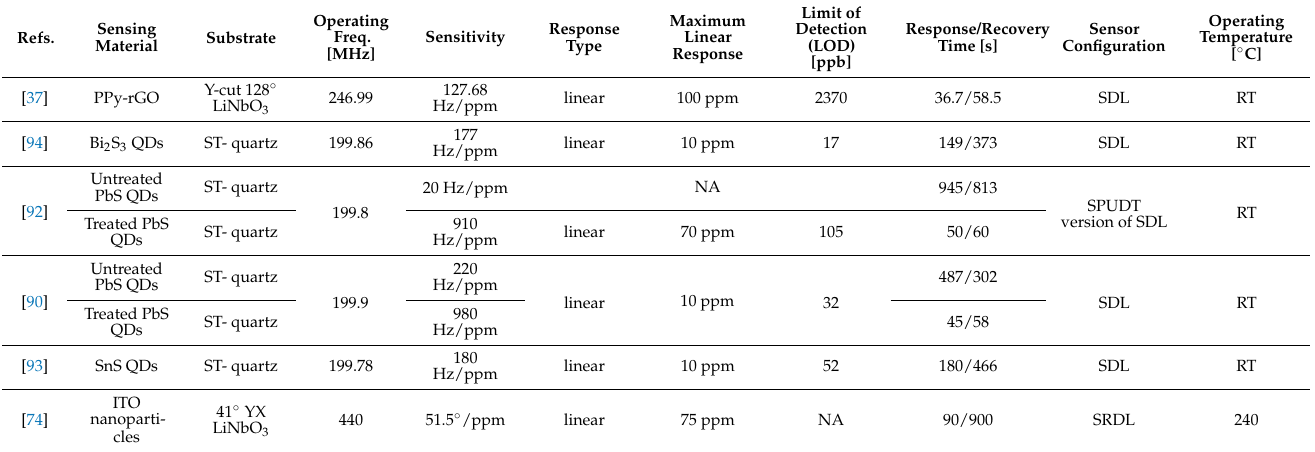
Table 3. Selected published work in SAW delay line configuration for NO 2